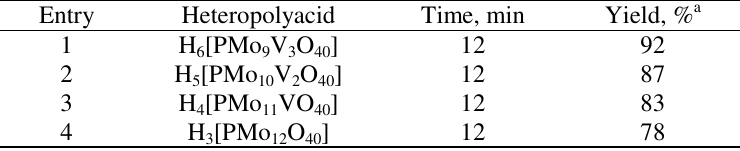
Table 1. Effect of various heteropolyacids, (2 mol%), on the yields of N